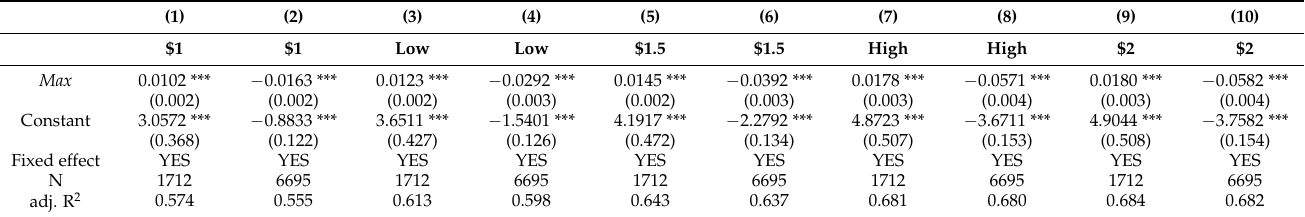
Table 11. Impact of extreme heat on poverty